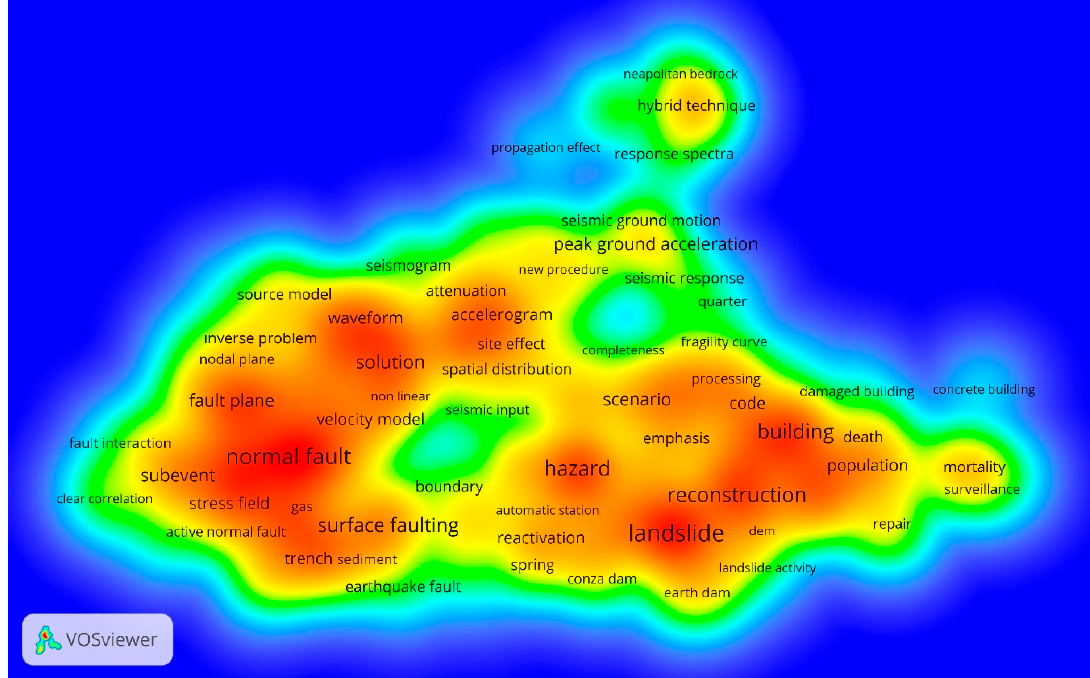
Figure 6. Density visualization by VOSviewer of IR_BASE_ENG database. The map shows the main terms leading the clusters and the connection between them.